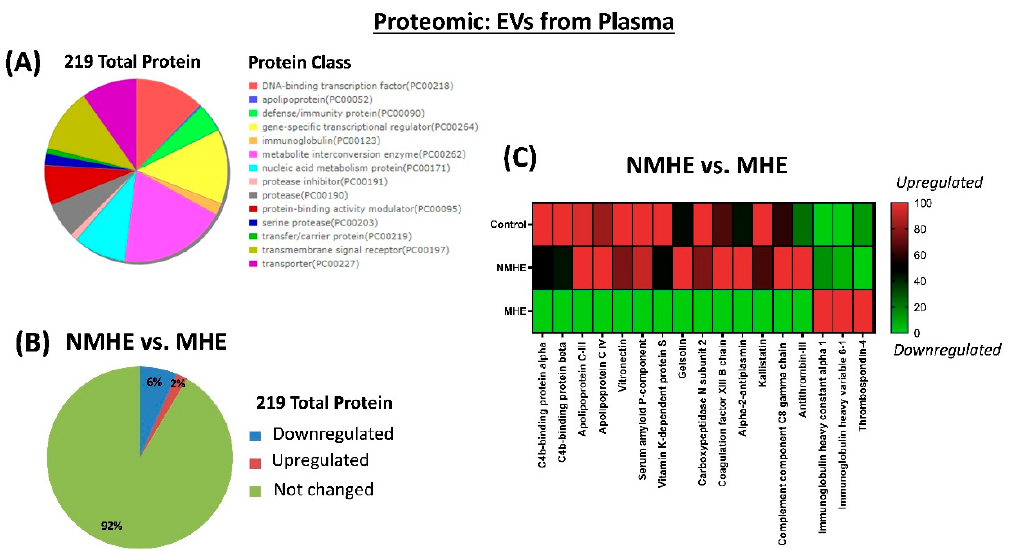
Figure 2. Proteomic profiling of EVs purified from plasma and differently expressed in patients with MHE. ( A ) Gene Ontology (GO) analysis to determine the protein class for the 219 proteins identified. ( B ) Percentage of the upregulated and downregulated proteins in MHE. ( C ) Heat-map of proteins differently expressed in EVs from patients with MHE and obtained by SWATH analysis as indicated in the methods. NMHE, MHE, patients without and with minimal hepatic encephalopathy, respectively.